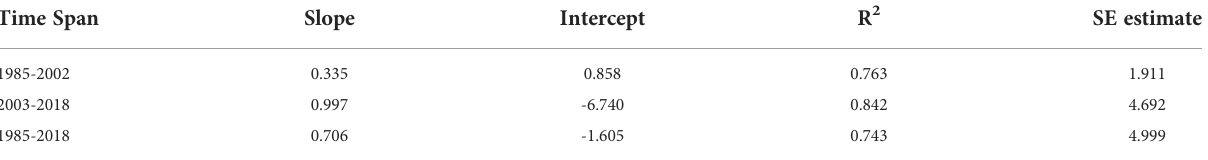
TABLE 3 Statistical comparisons of monthly global heat stress extent derived from 5-km CoralTemp and 25-km OISST . Time Span Slope